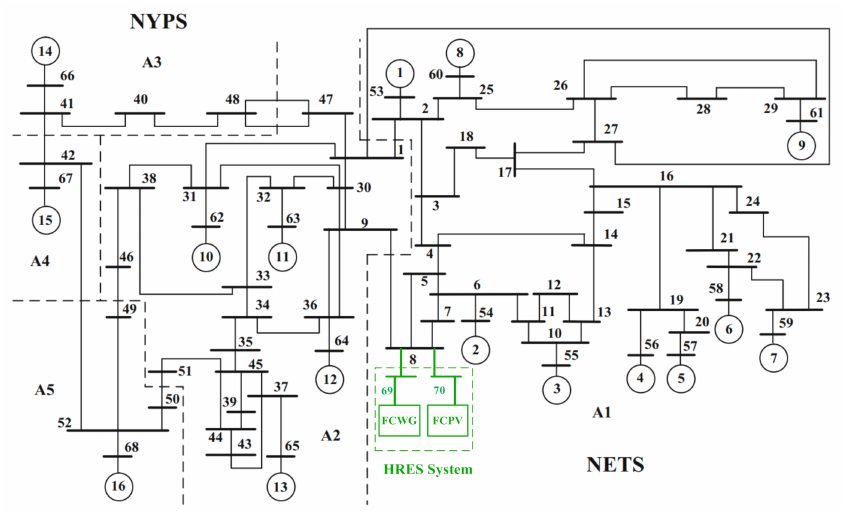
Figure 6. Configuration of test IEEE power system integrated with an HRES